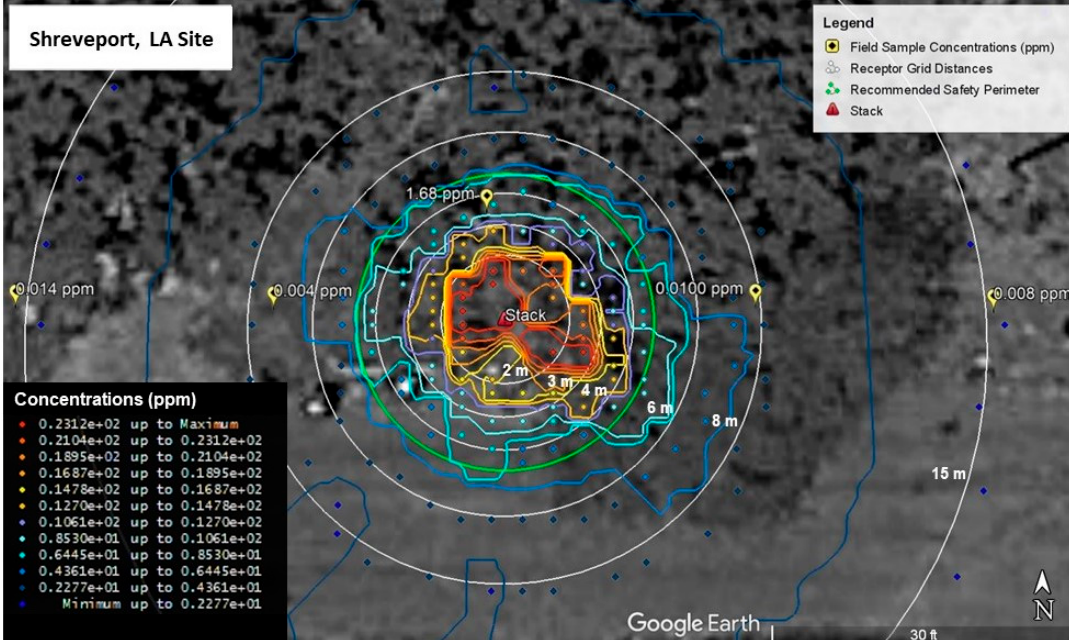
Int. J. Environ. Res. Public Health 2022 , 19 , 13800